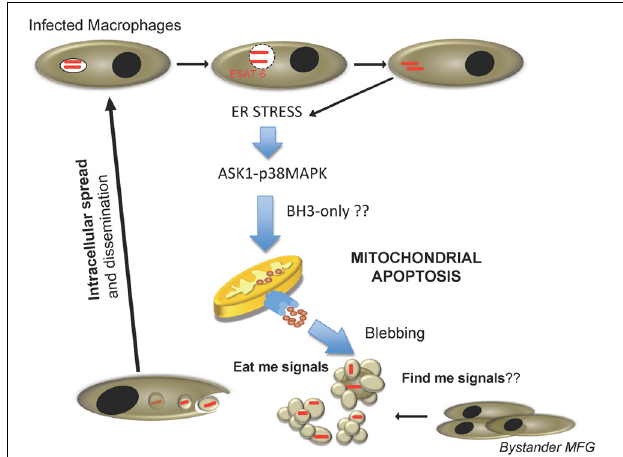
FIGURE 2 | Proposed cell-to-cell spread model for M. tuberculosis during host cell infection. Internalized M. tuberculosis disrupts phagosome in an ESAT-6 dependent manner. After reaching the cytosol, mycobacteria trigger ER stress, and activate pro-apoptotic cellular routes involving the ASK1-p38MAPK signaling axis, and causing host cell apoptosis by activation of the mitochondrial apoptotic pathway. Consequently, fresh macrophages are recruited and M. tuberculosis -containing apoptotic bodies are phagocytosed by new cells, re-starting the infection cycle.